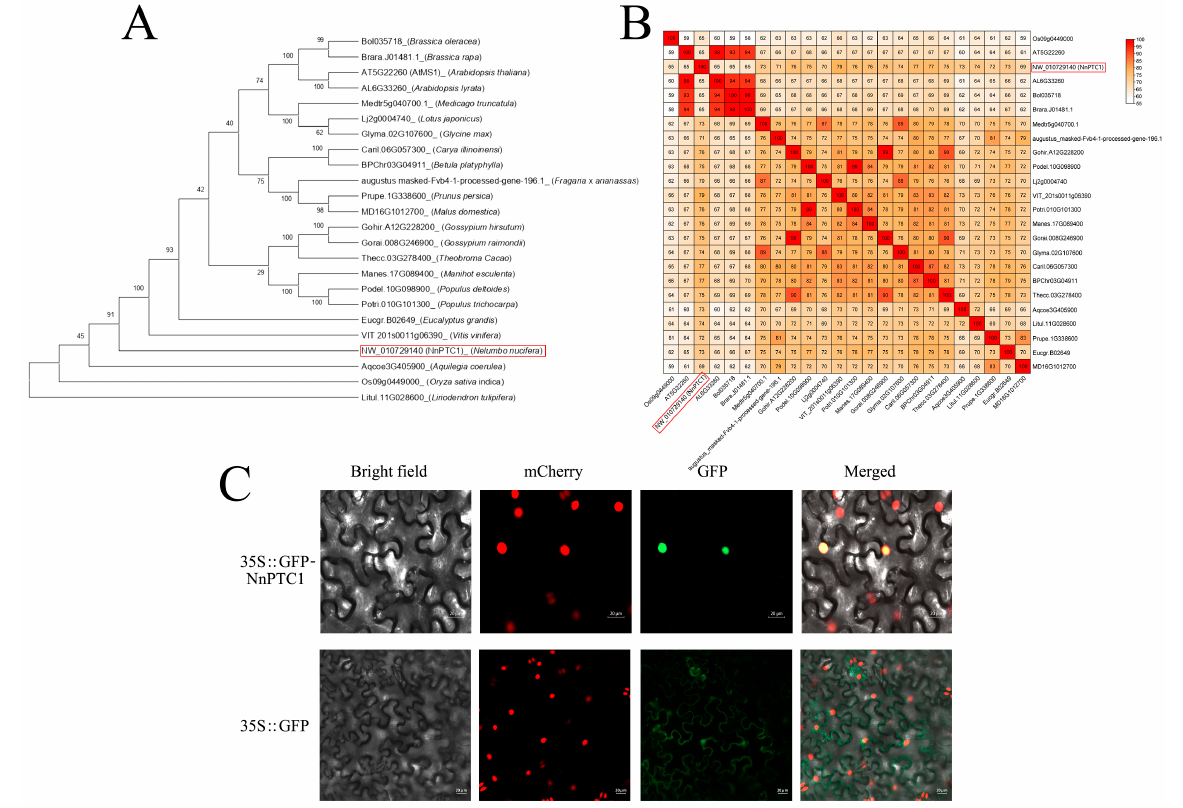
Figure 5. Basic information of NnPTC1 . ( A ) Evolution tree of PTC1 homolog genes. NnPTC1 in red box. ( B ) Comparison of NnPTC1 and homolog proteins in the red box. For details of NnPTC1 , please see Supplementary File S1. ( C ) NnPTC1 subcellular localization of GFP, green fluorescence protein; mCherry, red fluorescent dye; Merged, overlay plots.